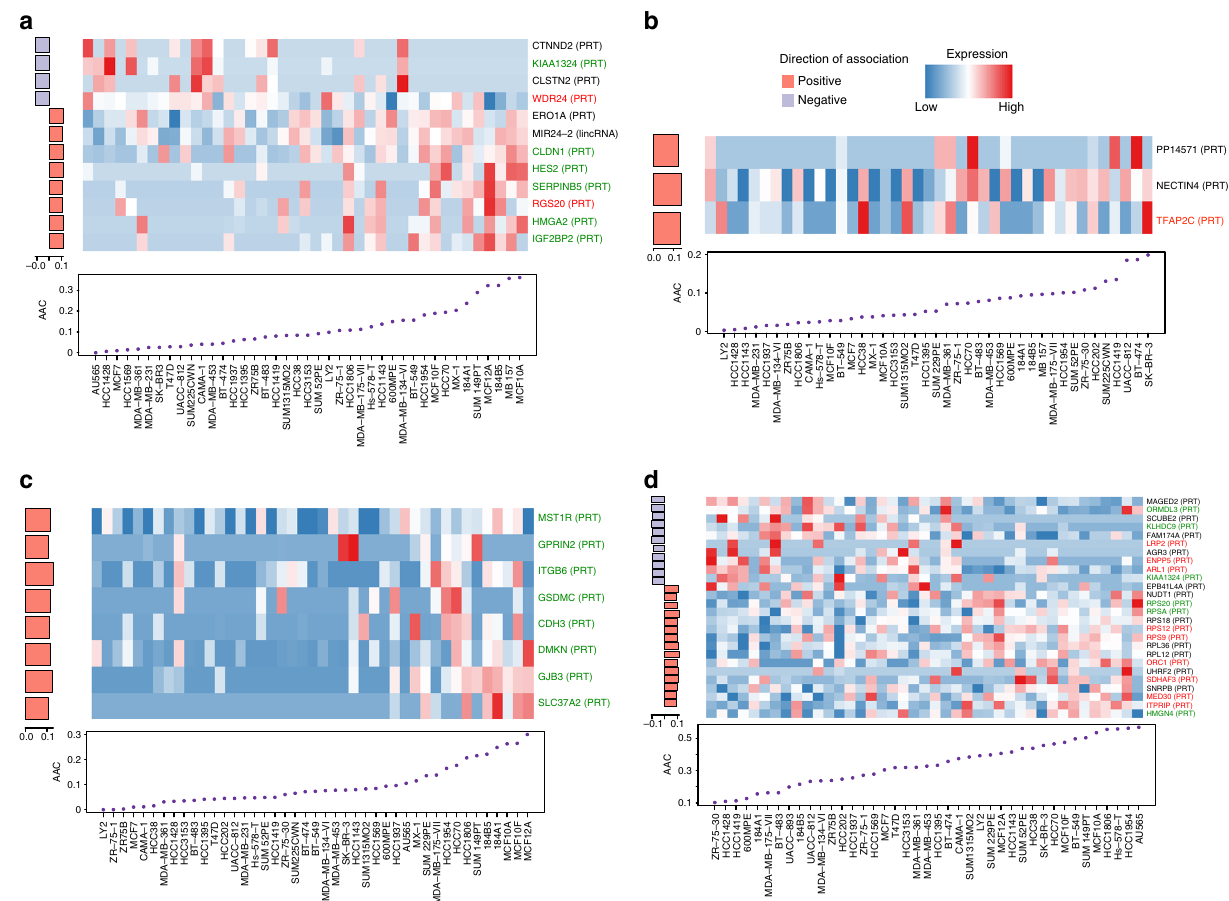
Fig. 5 Isoform-based biomarkers successfully pre-validated in the independent GRAY dataset for a AZD6244, b lapatinib c erlotinib, and d paclitaxel. Cell lines are ordered by their sensitivity to the drug of interest and their isoform expression is shown in the heatmap, with the drug sensitivity (AAC) plotted below. The left side barplot shows the predictive value of the associations between isoform expression and drug sensitivity as the concordance index minus 0.50 multiplied by the sign of the coef fi cient in the corresponding regression model. Genes for which the candidate isoform is signi fi cantly more predictive than its corresponding overall gene expression values are represented in green, red, when overall gene expression is more predictive than isoform, and black